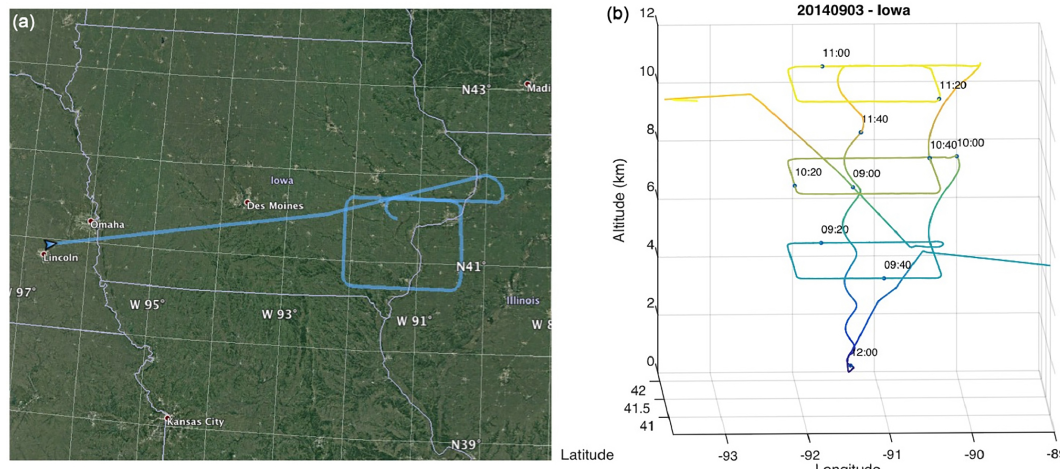
Figure 19. (a) Map of the flight track from Lincoln, Nebraska, from west to east, and a box pattern made over Iowa at dawn on the 2014 SF5 flight on 3 September 2014. (b) Plot of the time-tagged location and altitude for three-altitude box pattern during the same flight.